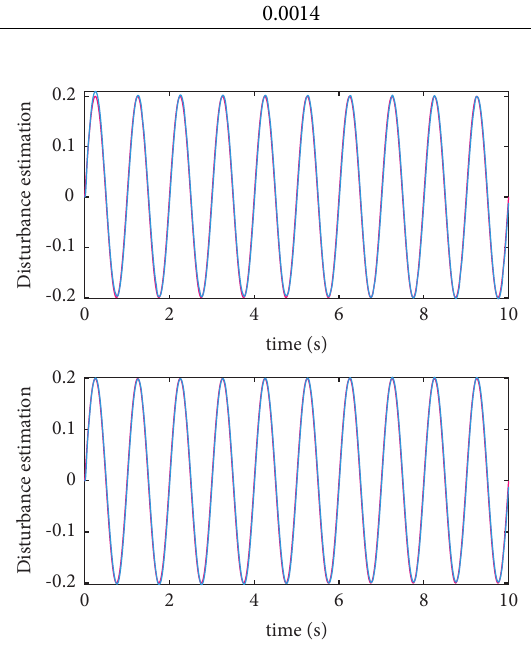
Figure 3: Disturbance